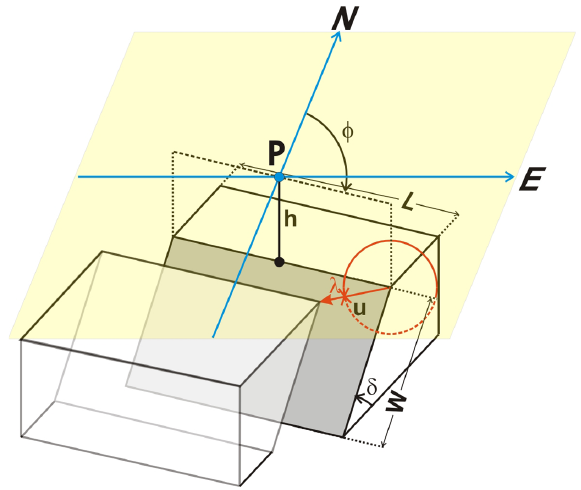
Fig. 2. Main parameters required to define the fault rupture that causes a tsunami, using the Okada (1985) elastic dislocation